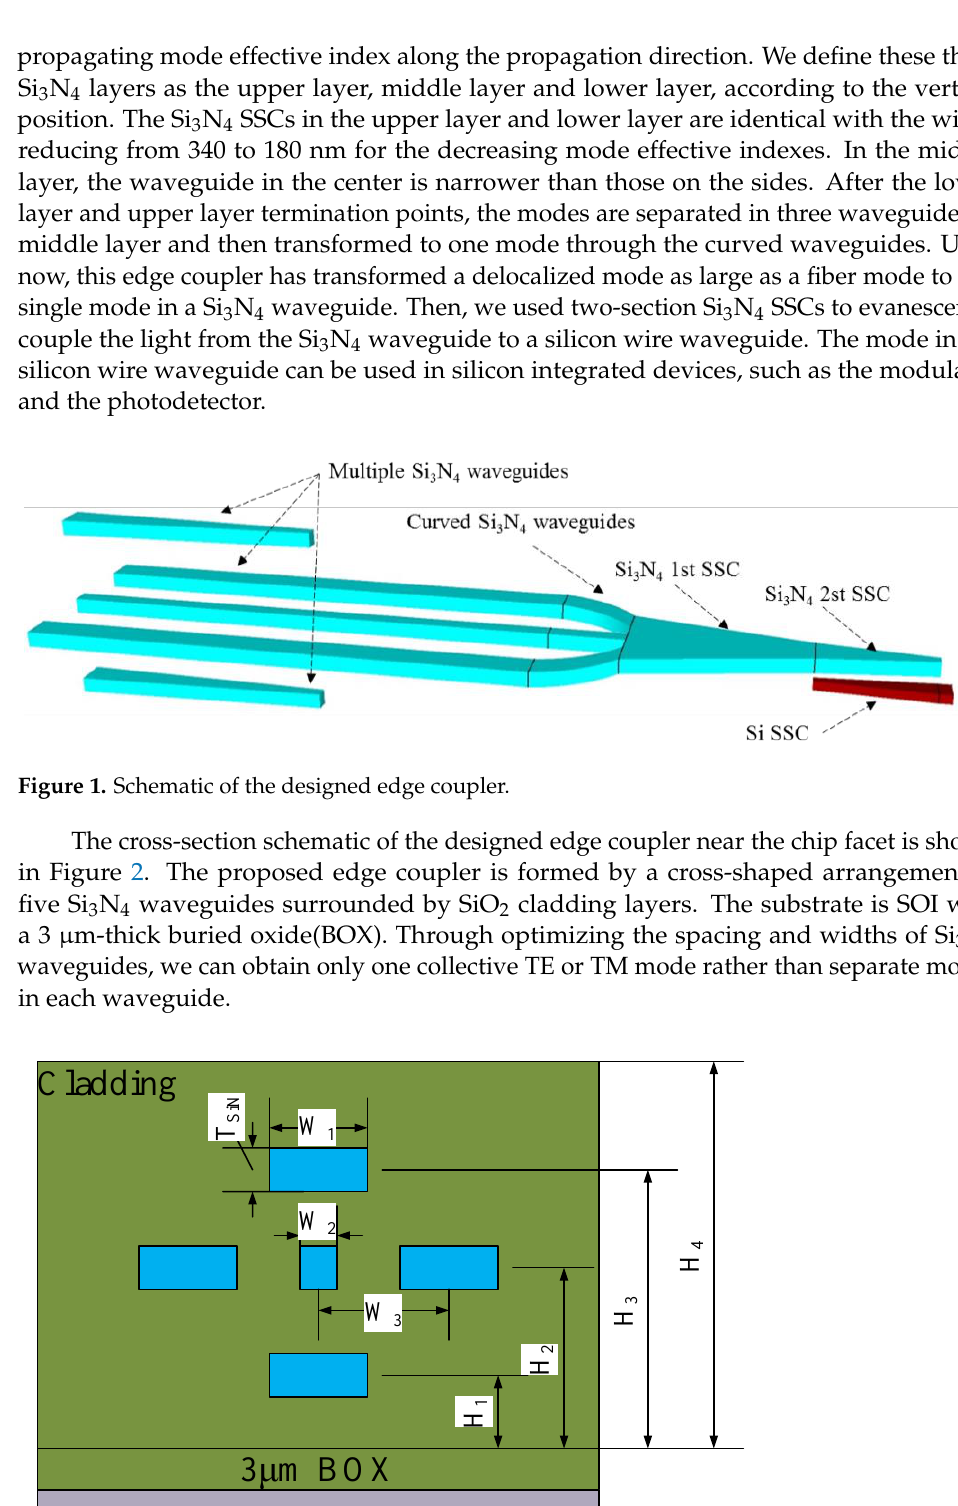
Figure 2. Cross-section schematic of the designed edge coupler near the chip facet.